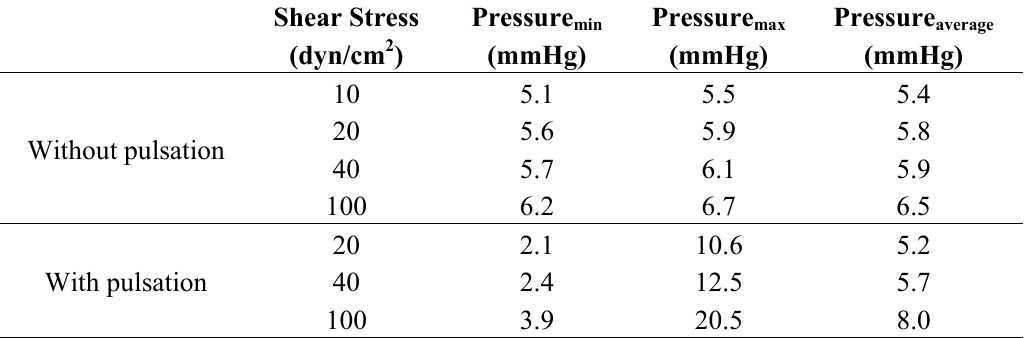
Table 1. Minimal, maximal and average pressure in the polyurethane (PU) scaffold under different shear stress values and with or without pulsation of the